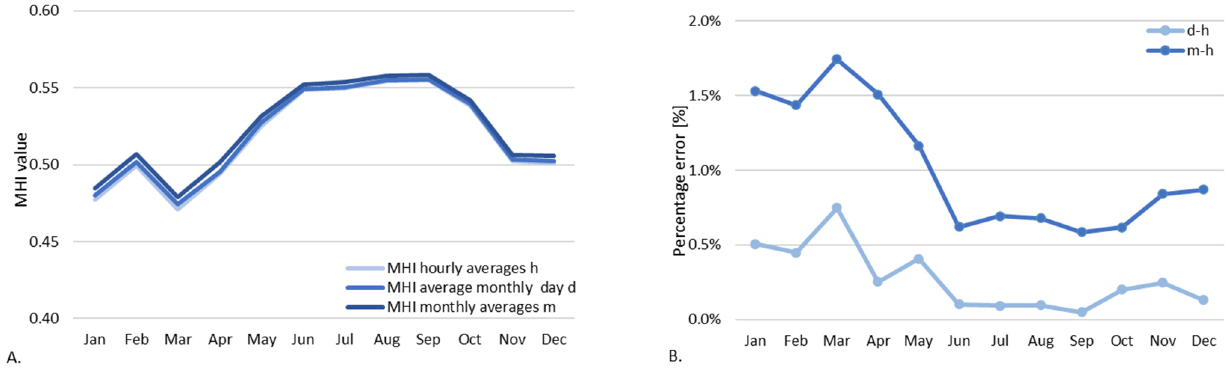
Figure 5. Havana WET values ( A ) and percentage error ( B ).